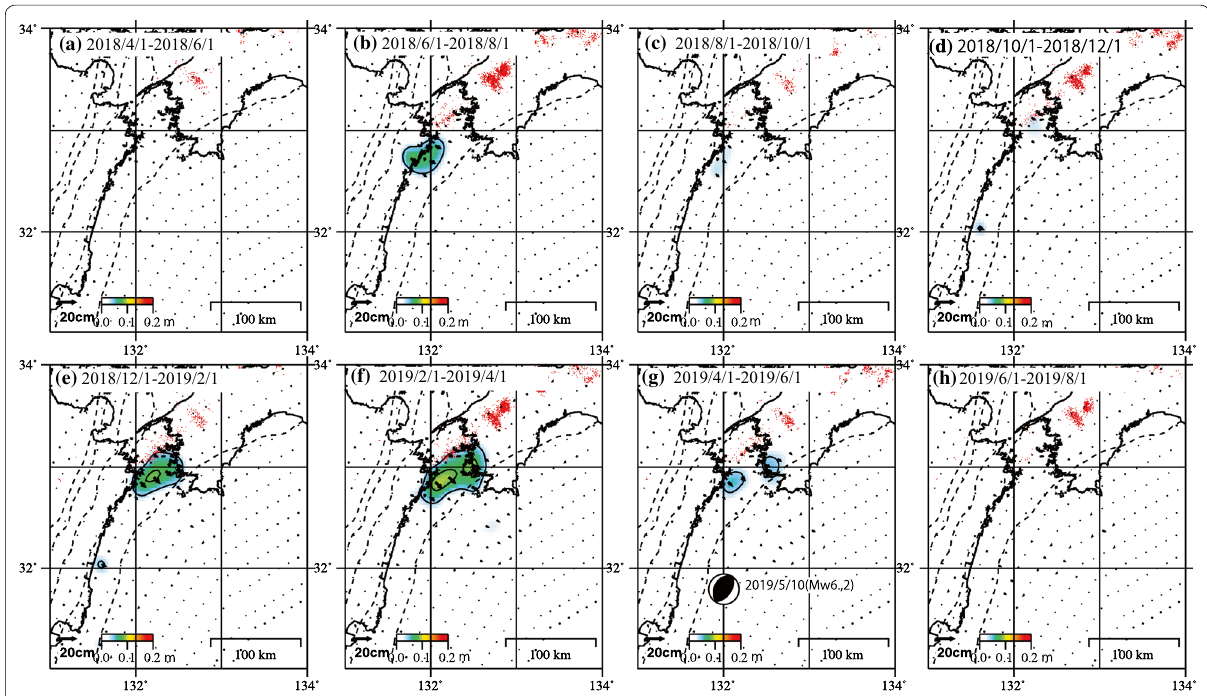
Fig. 4 Estimated interplate slip on the plate interface for the corresponding periods in Fig. 3. The color shows the magnitude of aseismic slip and solid arrows show the aseismic slip. The contour interval is 4 cm. Broken contours indicate iso-depth contours of the plate interface between the subducting Philippine Sea plate and the overriding Amur plate with a contour interval of 20 km. Red dots show the epicenters of low-frequency earthquakes for the corresponding period. The focal mechanism is shown at the epicenter of the Mw 6.2 Hyuga-nada earthquake on May 10,